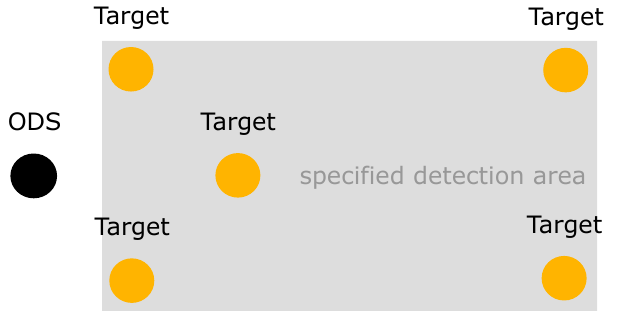
Figure 5. In the first test scenario, the ODS and test target are in a static state. The test target is in front of the ODS in their specified detection area (SDA).